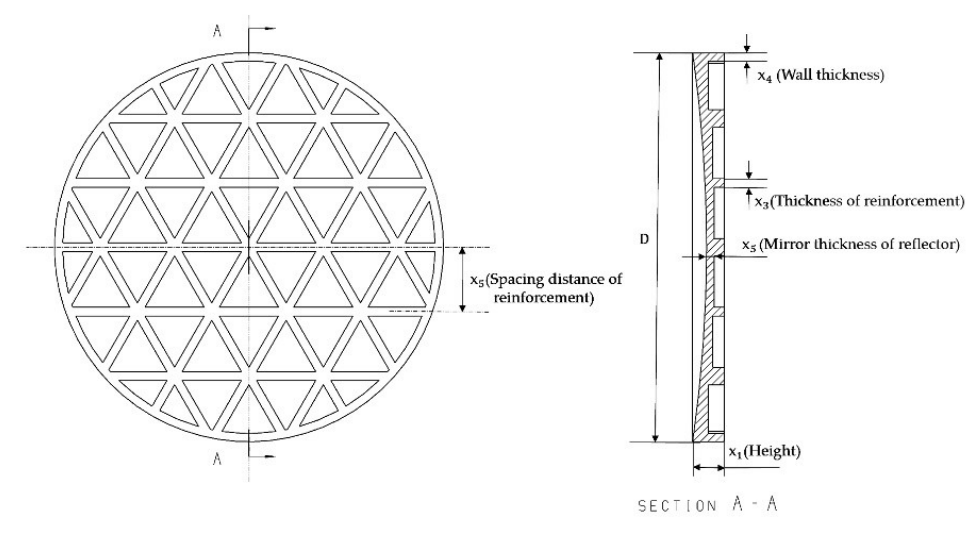
Figure 1. Schematic diagram of the structure of the reflector.